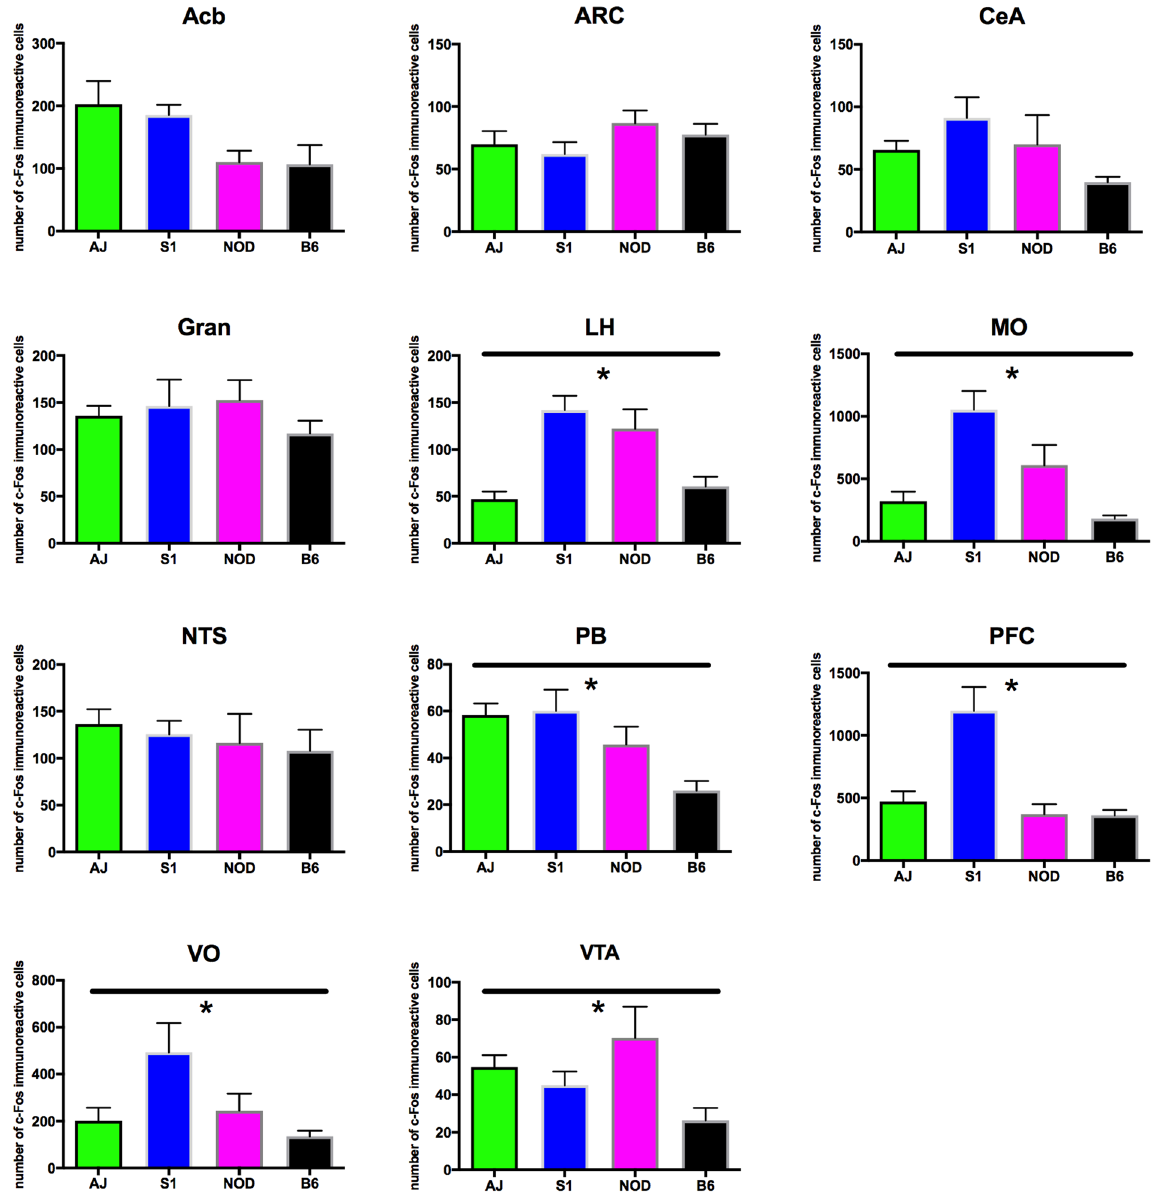
Figure 4. cFos expression in response to HCD feeding. Animals were fed 0.1 g HCD 90 minutes prior to sacrifice, with all animals consuming the test diet. cFos expression was then determined in brain areas shown previously to regulate food intake behavior. While cFos expression does not show variation between mouse strains in select brain nuclei (A, Acb, B, Arc, C, CeA, D, Gran and G, NTS). cFos expression in the LH (E), MO (F), PB (H), PFC (I), VO (J), VTA (K) all exhibited genotype dependent differences (ANOVA, p < 0.05, Benjamini-Hochberg p-value correction for multiple